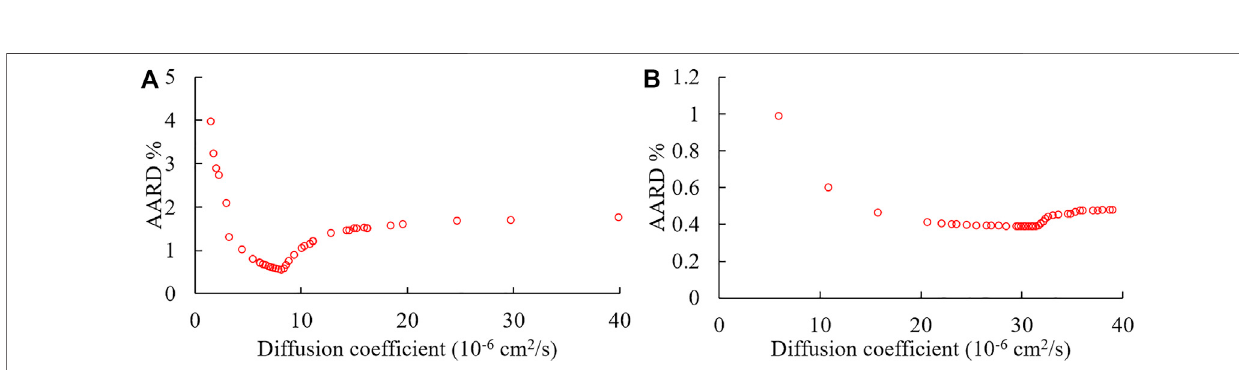
Frontiers in Earth Science |